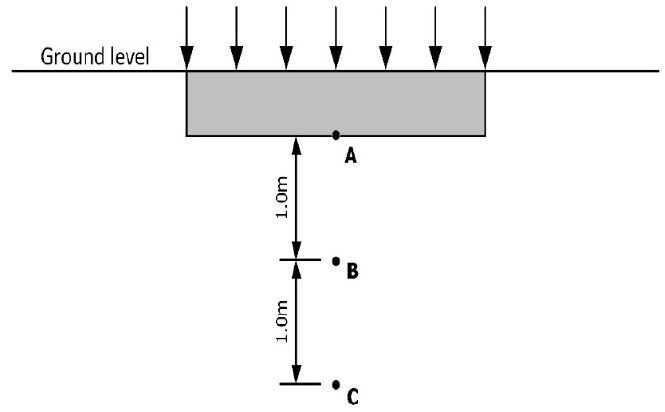
Figure 4. Selected nodes for boundary sensitivity analysis. Table 5. Influence of the lateral boundary distance upon footing settlement.